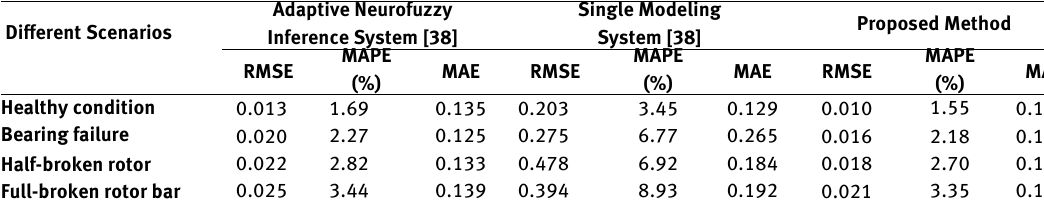
Different Scenarios